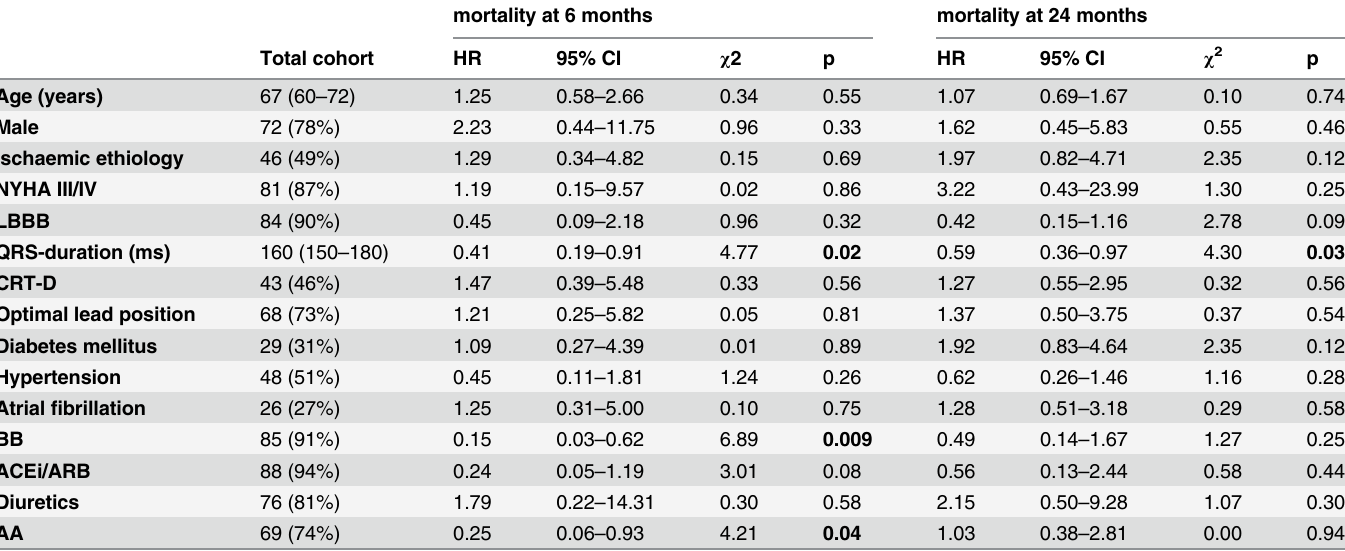
Table 1. Patient baseline clinical characteristics and univariate Cox regression analysis for prediction of mortality at 6 and 24 months after CRT- implantation. mortality at 6 months